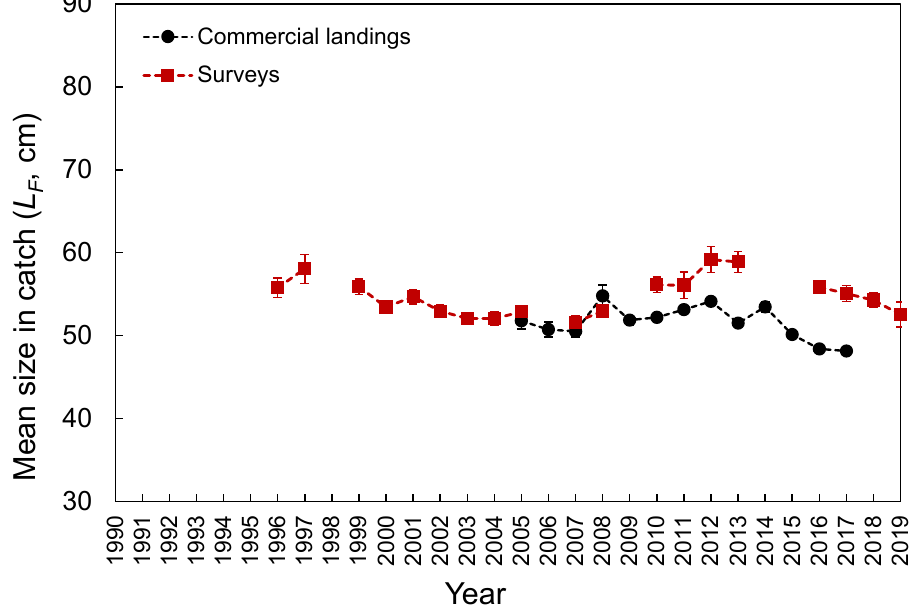
Figure 5. Annual Mean ( ± 0.95 confidence interval) fork length ( L F ) of Mora moro derived from the surveys and commercial landings in the Azores.